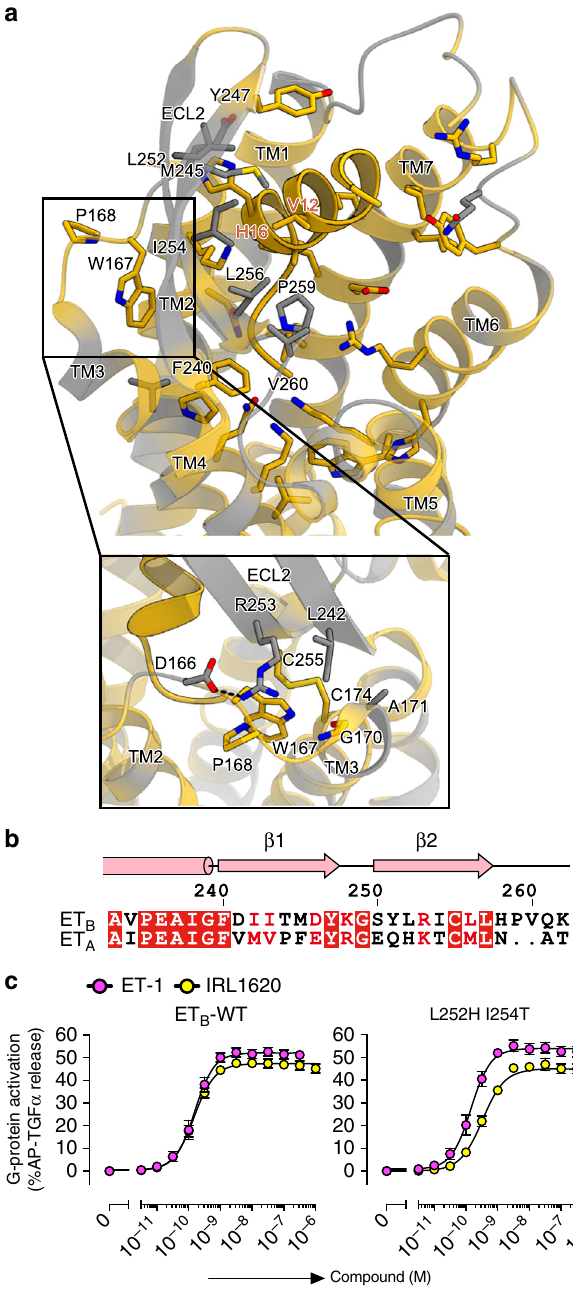
Fig. 4 Conservation of the IRL1620 binding site. a Sequence conservation between ET A and ET B , mapped onto the IRL1620-bound structure. The upper panel shows the conservation of the residues constituting the IRL1620 binding site. Conserved and non-conserved residues are coloured orange and grey, respectively. The ET B receptor is shown as ribbons, and the residues involved in IRL1620 binding are shown as sticks. Moreover, W167 and P168 in ECL1 are shown as sticks. The lower panel shows the conservation of the ECL1-ECL2 interface. b Alignment of the amino acid sequences of the human ET B and ET A receptors, focused on ECL2. c